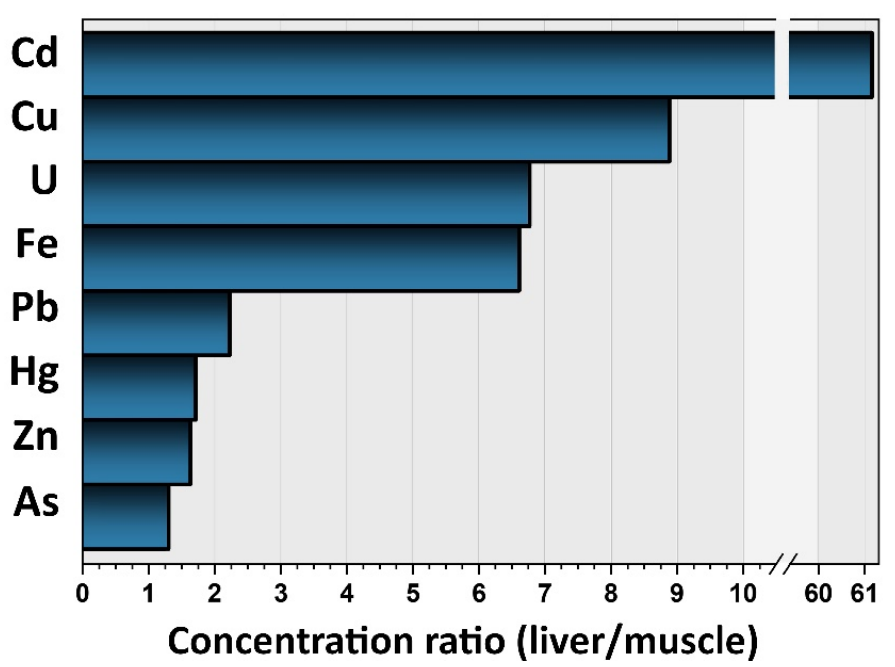
Figure 2. Concentration ratios (liver/muscles) of toxic metals and metalloids (TMMs) in the analyzed pig samples.